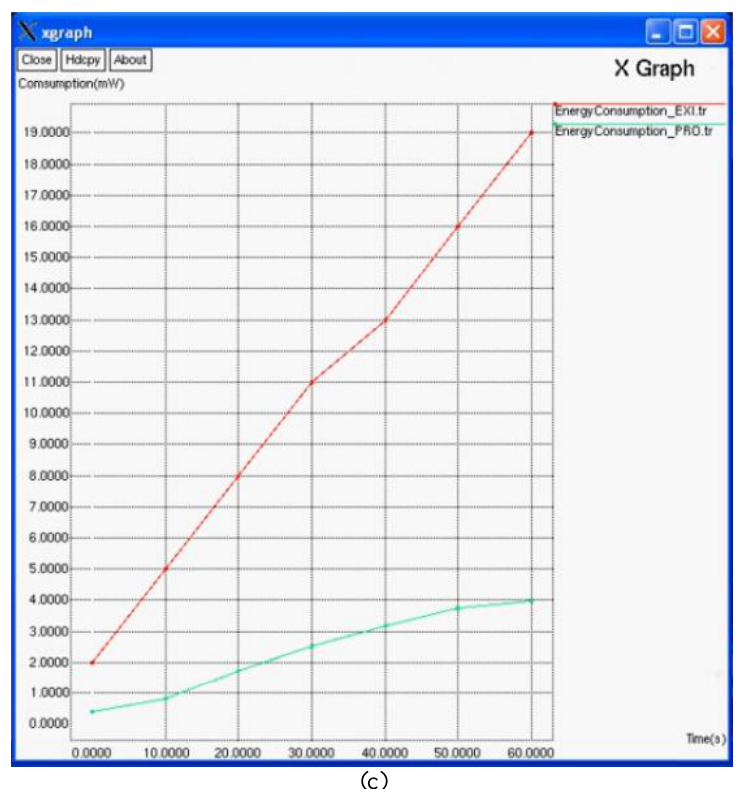
Figure 6. Performance evaluation based on: (a) Packet delivery ratio, (b) Average delivery latency or end to end delay, (c) Energy